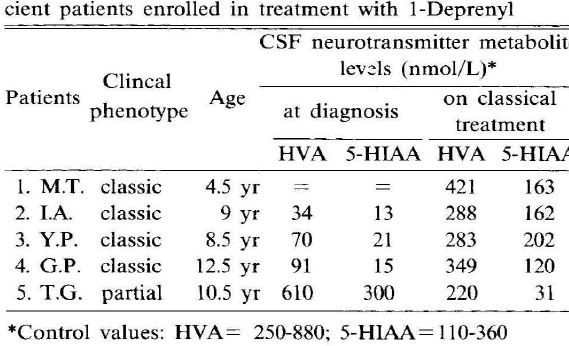
Table 1. Clinical and biochemical data of five PTPS defi- cient patients enrolled in treatment with 1-Depreny1 CSF neurotransmitter metabolite lenls (nmol/L)* Clincal Patients Age on classical phenotype at diagnosis treatment